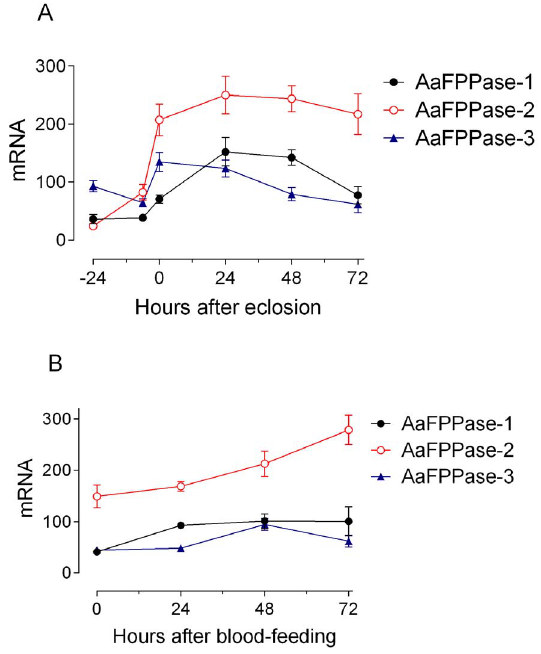
Figure 6. Developmental expression of Aa FPPases. A) Expression on pupae and sugar-fed females: mRNA was isolated from CA of pupae 24 h ( 2 24) and 6 h before adult eclosion, newly emerged adult female (0 h), sugar-fed females 24, 48 and 72 h after eclosion. B) Expression after blood feeding. Each data point is the means 6 S.E.M. of three independent biological replicates of 20 CA evaluated in triplicate. Aa FPPase mRNAs are expressed as copy number of mRNA/10,000 copies of rpL32